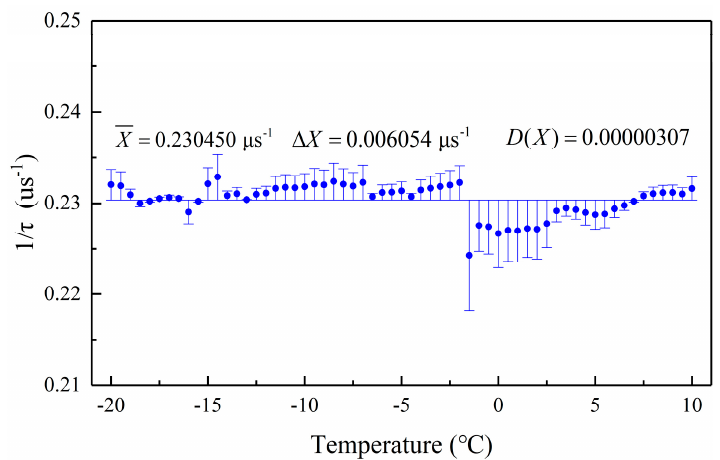
Figure 9. Stability test results of temperature ranged from − 20 ℃ to 10 ℃ .